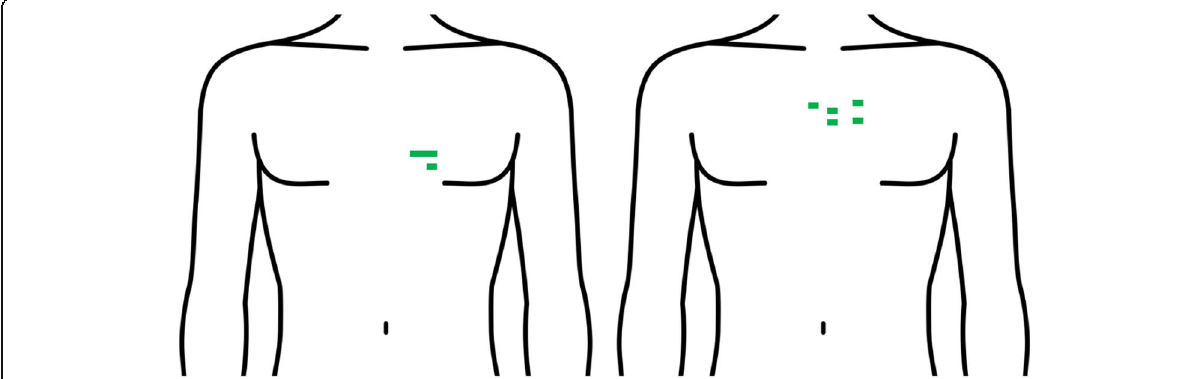
Fig. 2 Location of stab wounds in patients 3 (left panel) and 4 (right panel). The green lines indicate the location of the stab wounds. (The figure was obtained from https://pixta.jp/illustration/37387380 and is reproduced with permission)